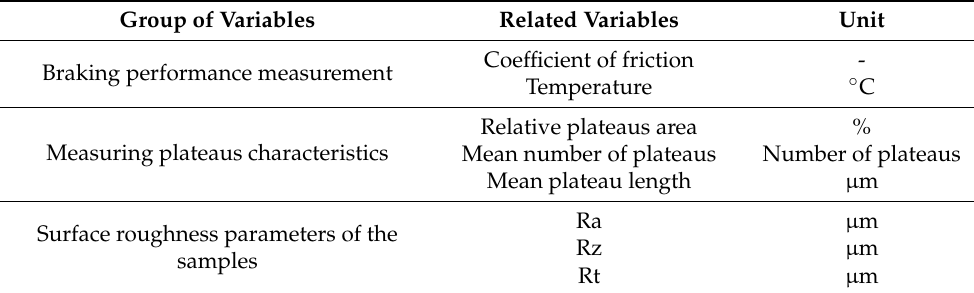
Table 1. Variables manipulated for the analysis of the vehicle experiments.